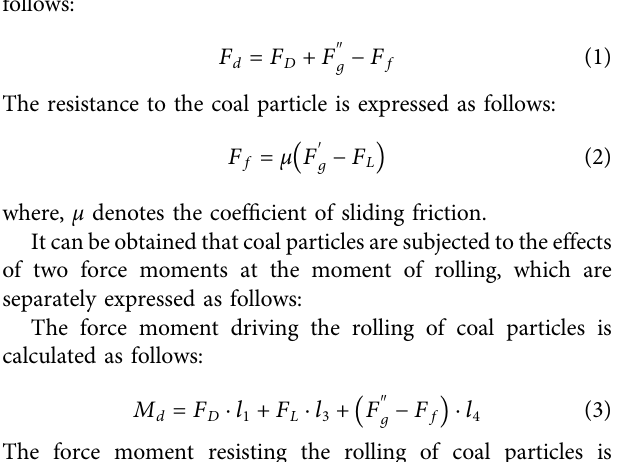
Frontiers in Earth Science |